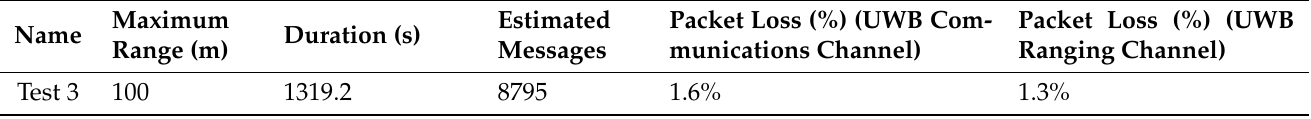
Table 8. Results in test 3 of the amount of communications exchanged and ranging